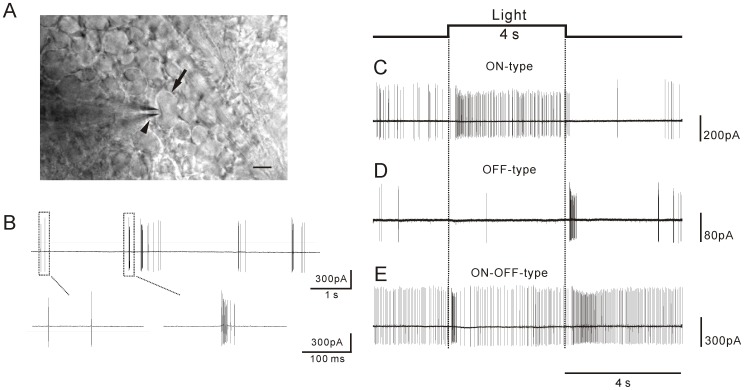
Spontaneous and light-evoked spike activity of retinal ganglion cells.A. A DIC image taken from the ganglion cell layer in a whole-mount mouse retina (scale bar indicates 10 µm). The arrow and arrowhead point to the soma of a representative α-type ganglion cell and the recording pipette, respectively. B. Spontaneous activity of an α-type ganglion cell. The cell exhibited a mixture of single spikes (left inset) and bursts (right inset). Typical recordings of representative ganglion cells showing ON (C), OFF (D), and ON-OFF (E) responses to 4-s full-field light stimuli (indicated by square wave above response traces; light intensity: 1.06×109 photons/cm2/s).